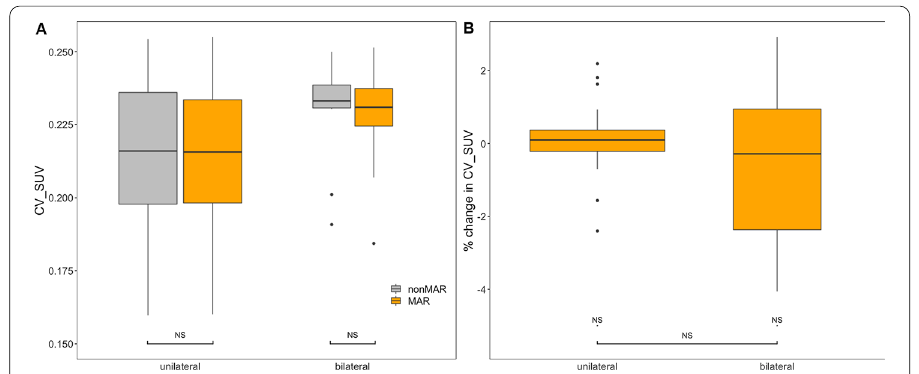
Fig. 11 Effect of MAR on the variation coefficient of the SUV in the bladder. Panel A is a boxplot describing the variation coefficient of the SUV according to whether or not MAR was applied for PET attenuation correction. Panel B is a boxplot describing the percentual change of the variation coefficient induced by MAR. Boxes and whiskers are as in Fig. 7. Statistical significance of the difference with use of MAR is indicated in panel A ; in panel B it is indicated whether the percentual increase in the variation coefficient differs significantly from 0 (NS denotes not significant, * p < 0.05, ** p < 0.01, *** p < 0.001). CV_SUV variation coefficient of SUV